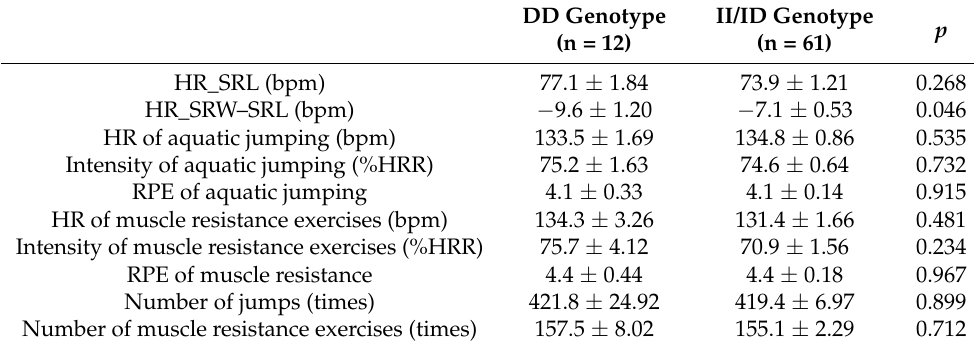
Table 2. Comparison of HR, movement numbers and RPE with different genotypes.